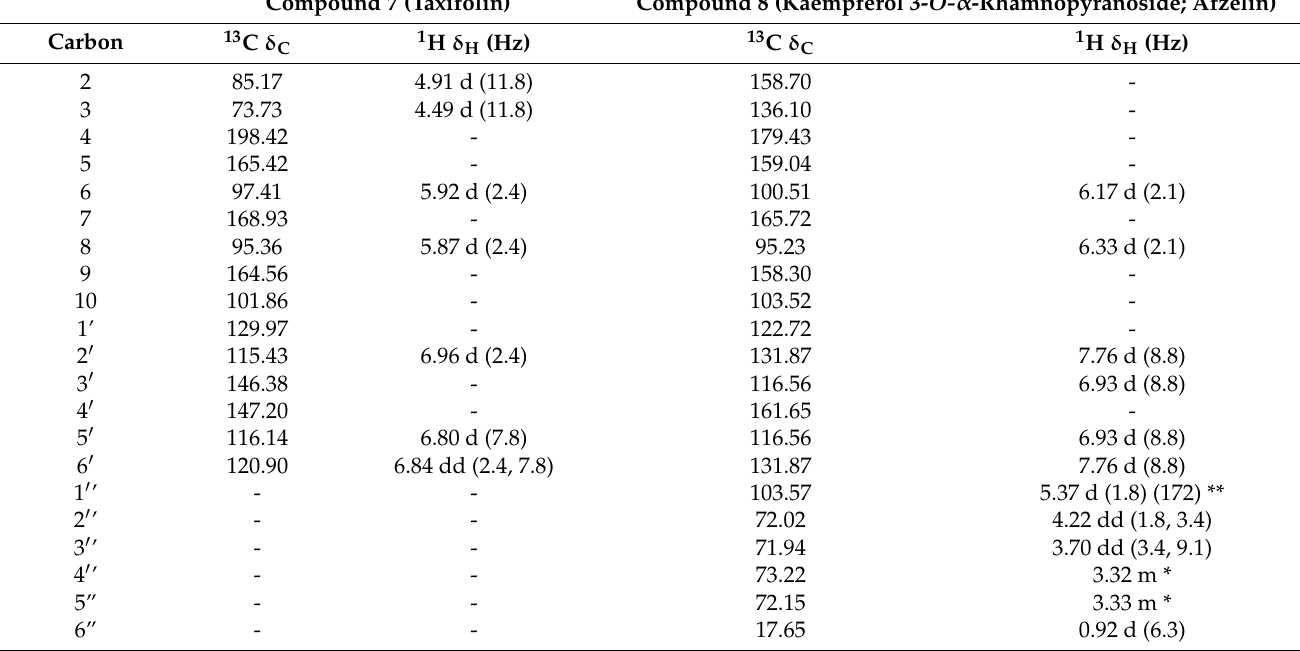
Table 1. NMR Data of Compounds 7 and 8